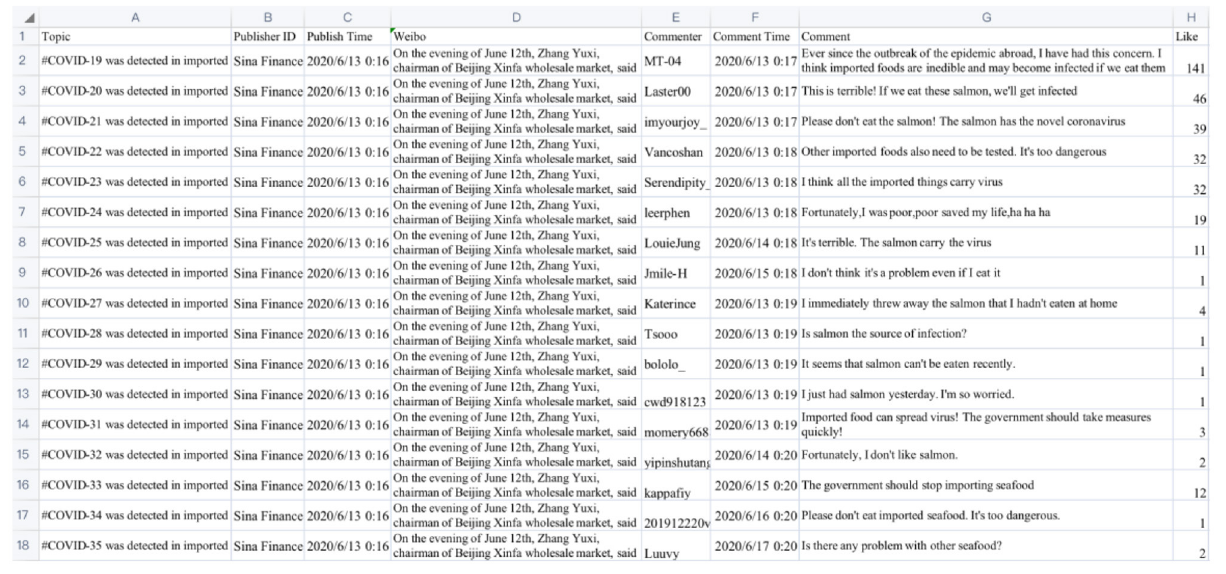
FIGURE 20 | Schematic diagram of the data.